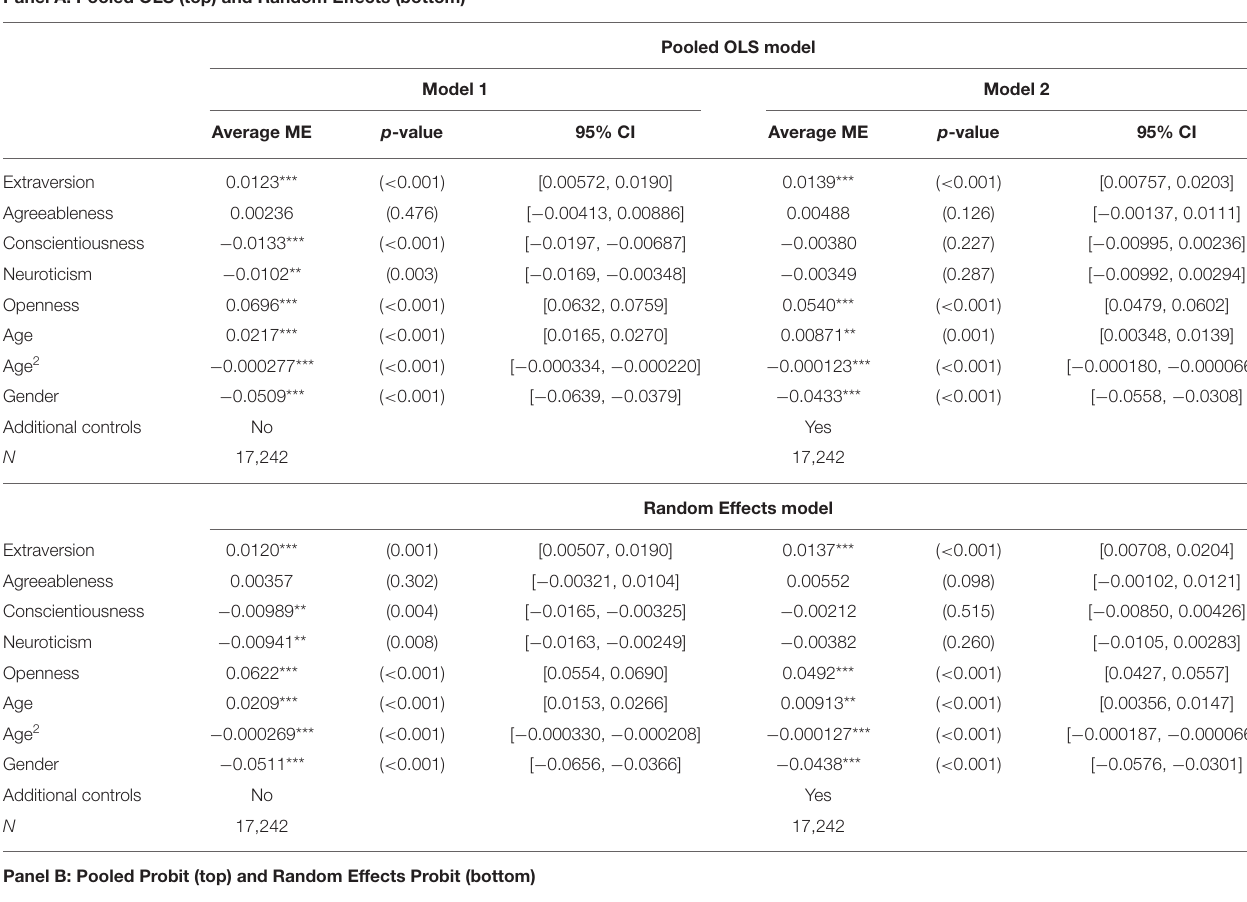
TABLE 6 | Big Five Personality Dimensions and participation in overall further training. Panel A: Pooled OLS (top) and Random Effects